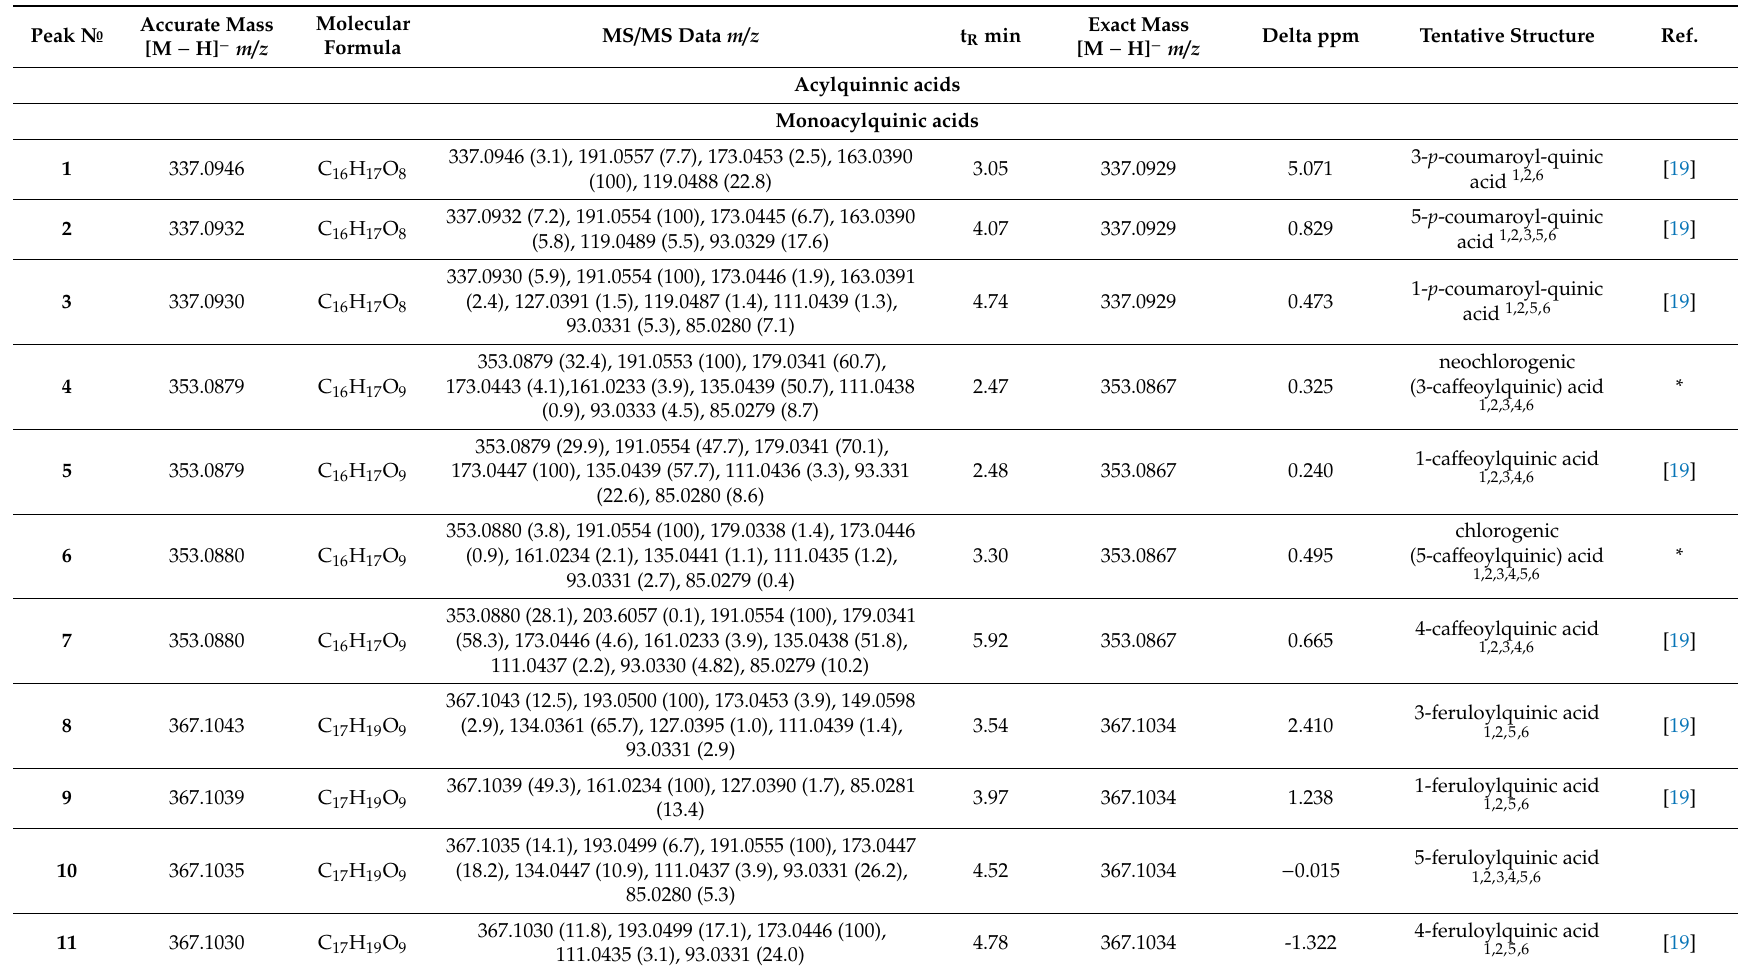
Table 2. Peak assessment of compounds in Anthemis